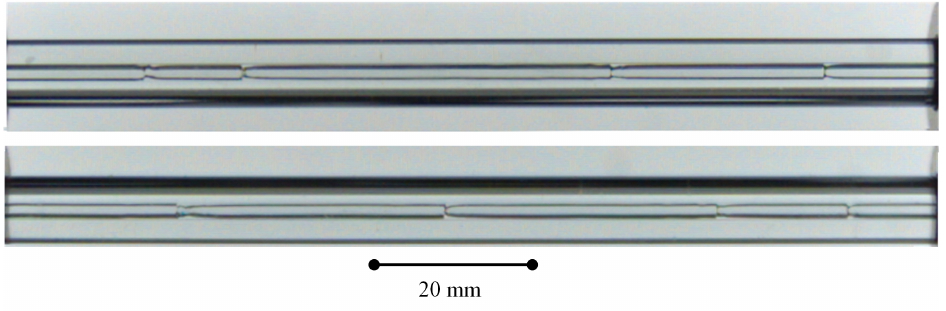
Figure 7. Common structure of elongated bubbles regime in the adiabatic section for the case of 100 W input power and ethanol as working fluid—52.6% filling